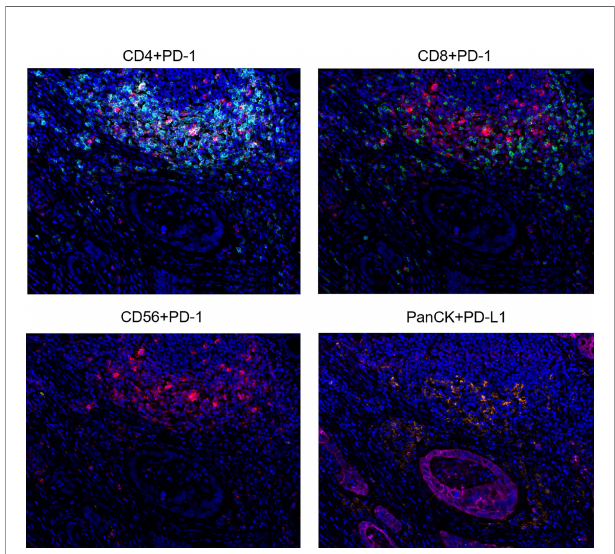
FIGURE 3 | Representative multiplex immuno fl uorescence images of co- expression of PD-1 on CD4, CD8, CD56 cells, and PD-L1 on tumor cells. Color scheme - Cyan: CD4, Green: CD8, Yellow: CD56, Red: PD-1, Orange: PD-L1, Magenta: PanCK, Blue: